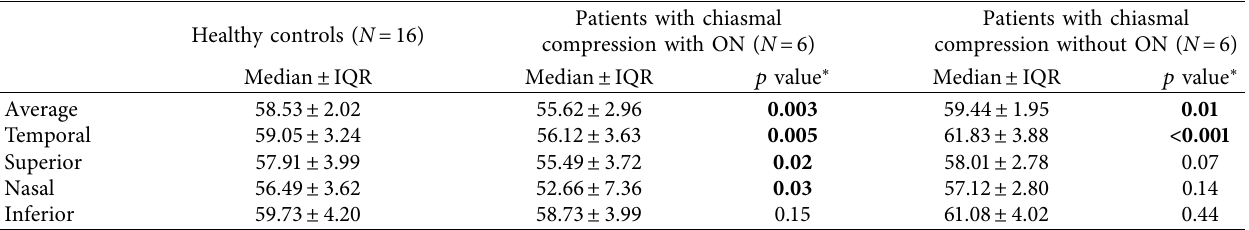
∗ Variables are displayed as mean ± standard deviation. ∗∗ Variables are displayed as median ± interquartile range. † Estimated using generalized estimating equation regression models. ON � optic neuropathy, RNFL � retinal nerve fiber layer, GCC � ganglion cell complex. No significant differences were found in gender and age between patients with chiasmal compression and healthy controls. No disc swelling was detected in the group of patients with chiasmal compression on fundus examination. In total, 13 eyes (54.2%) had acquired dyschromatopsia (eight in the group of patients ON+). Vessel density of theradial peripapillary capillary before surgery. Bold values represent statistical significance. Table 3: Vessel density comparison between healthy controls and patients with chiasmal compression with and without optic neuropathy.